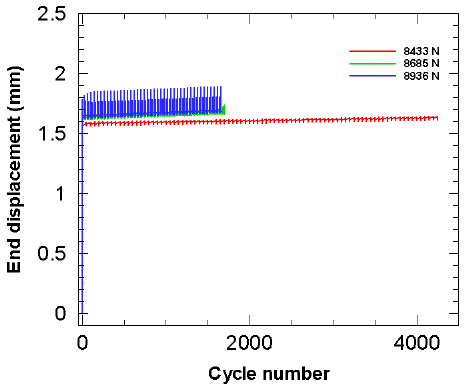
Figure 11. End displacement of the CG specimen under three axial loads.